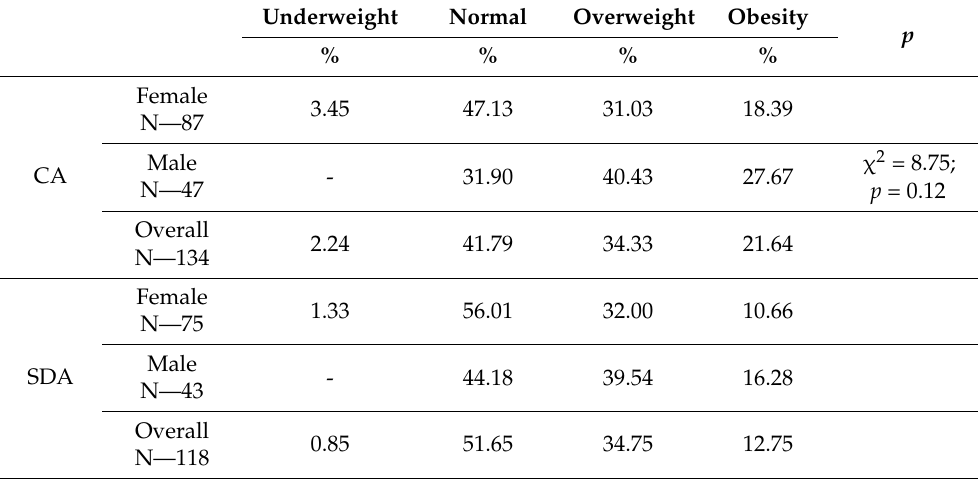
Table 4. Results of BMI in the study group of SDA and CA: overall, according to gender. Underweight